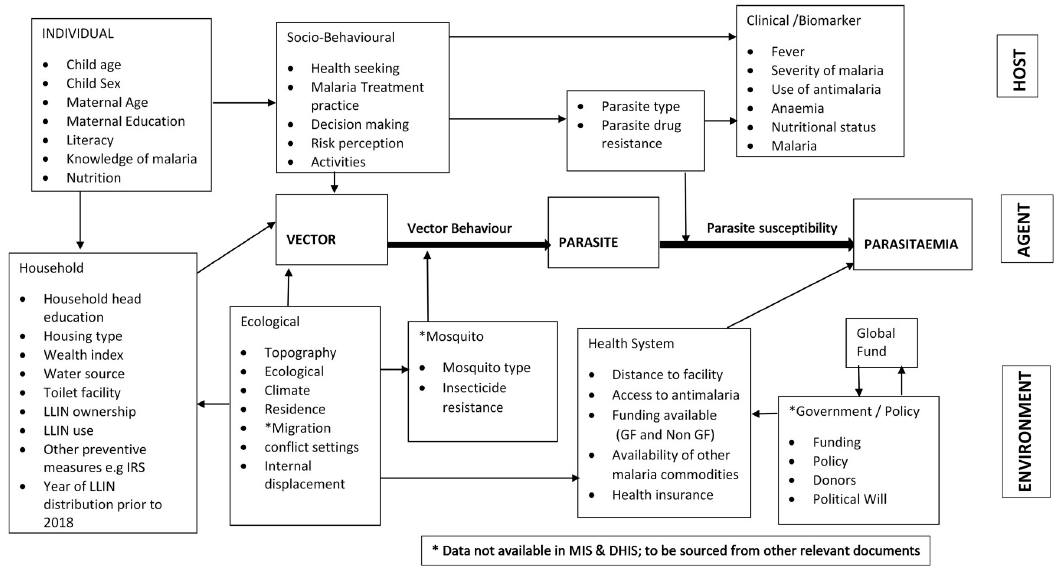
Fig 1. Conceptual framework on the driving forces that influence the change of parasitaemia in 13 States with high malaria burden.